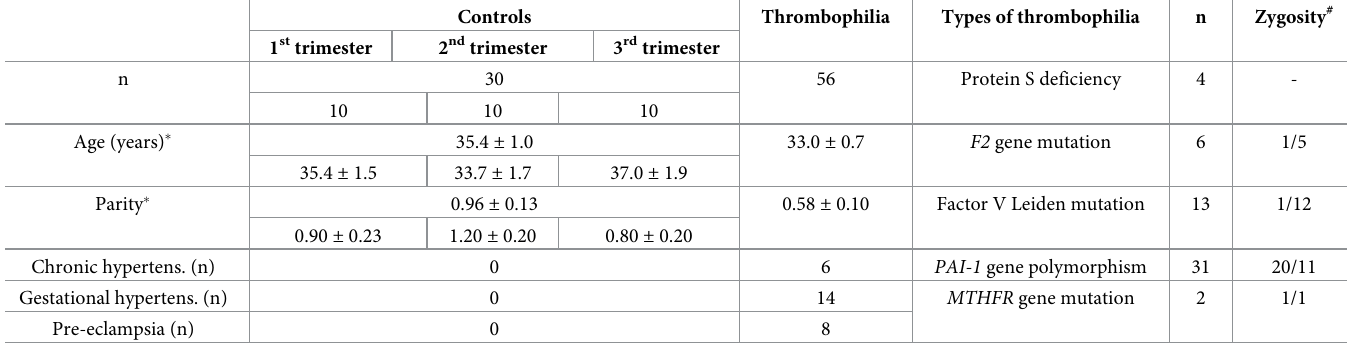
Table 1. Population